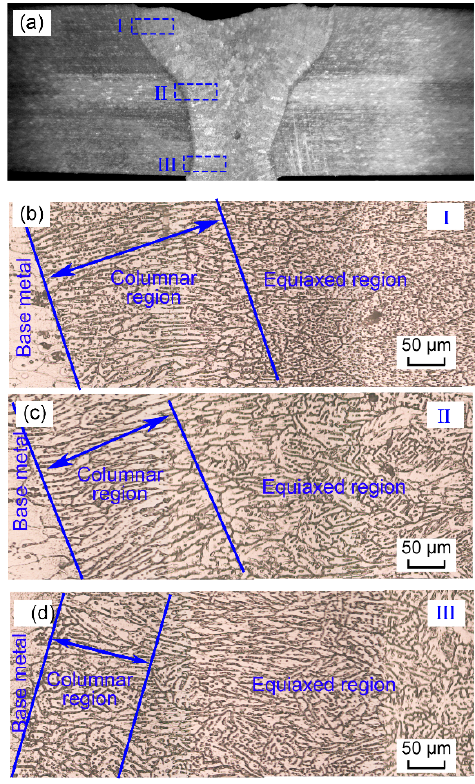
Figure 3. ( a ) Three different locations, i.e., upper (Region I), middle (Region II), and bottom (Region III), in the laser weld; ( b – d ) optical micrograph corresponding to Regions I, II, and III, respectively.